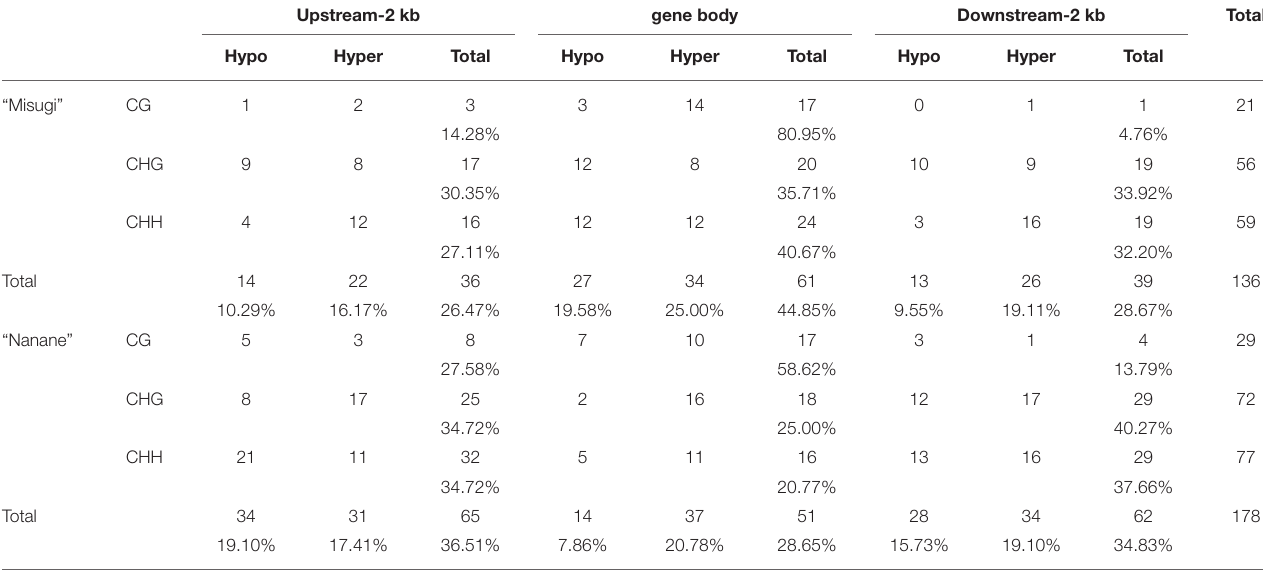
TABLE 2 | Differentially methylated regions (DMRs) associated with gene body, upstream, and downstream of genes in B. rapa cultivars “Misugi” (susceptible) and “Nanane” (resistant). Upstream-2